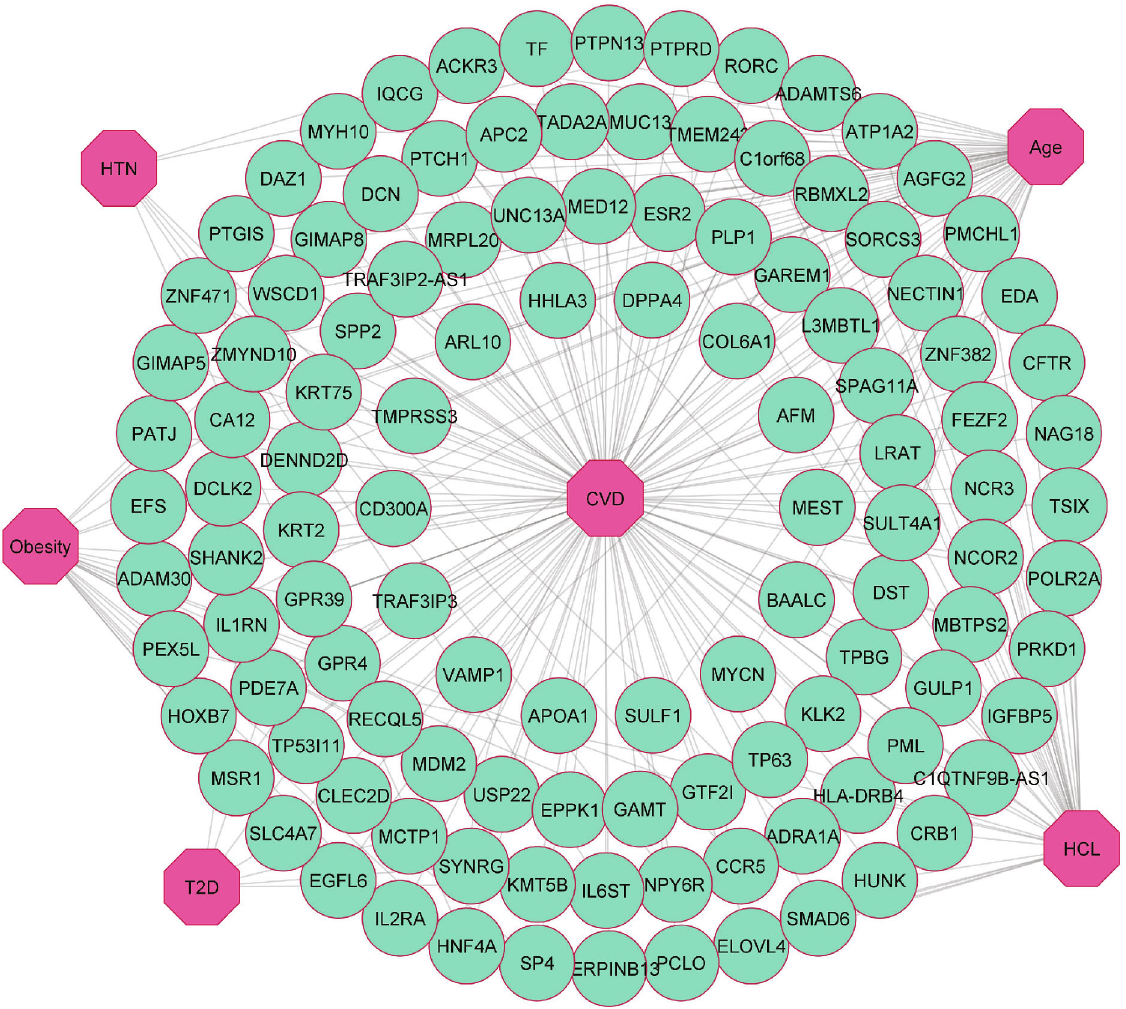
Figure 3: Diseasome network of the downregulated genes that are common between CVD and HTN, T2D, HCL, obesity, and aging. Circular green-colored nodes represent shared downregulated genes, and octagon-shaped nodes represent CVD and its risk